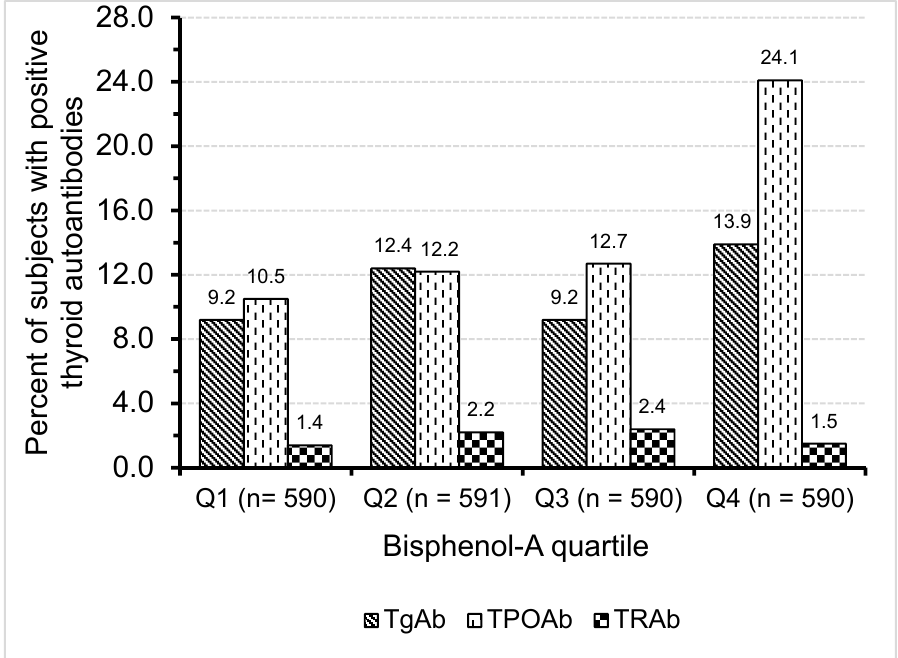
Figure 1. Percent positive rate of thyroid autoantibodies in relation to BPA quartiles.